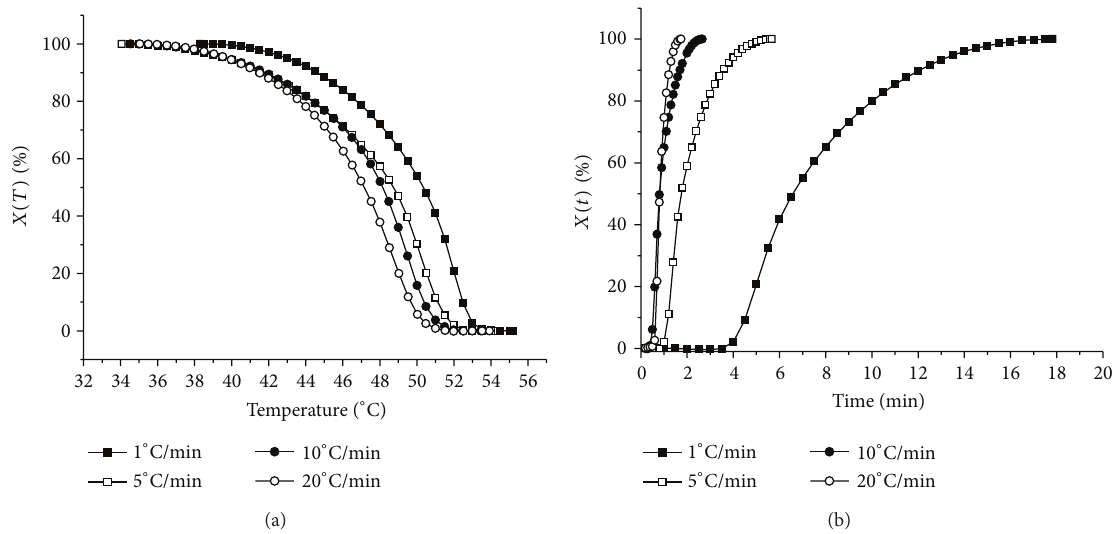
Figure 3: Plots of 𝑋(𝑇) versus temperature (a) and plots of 𝑋(𝑡) versus time (b) for crystallization of MAG organogels at four different cooling rates (1, 5, 10, and 20 ∘ C/min, resp.).